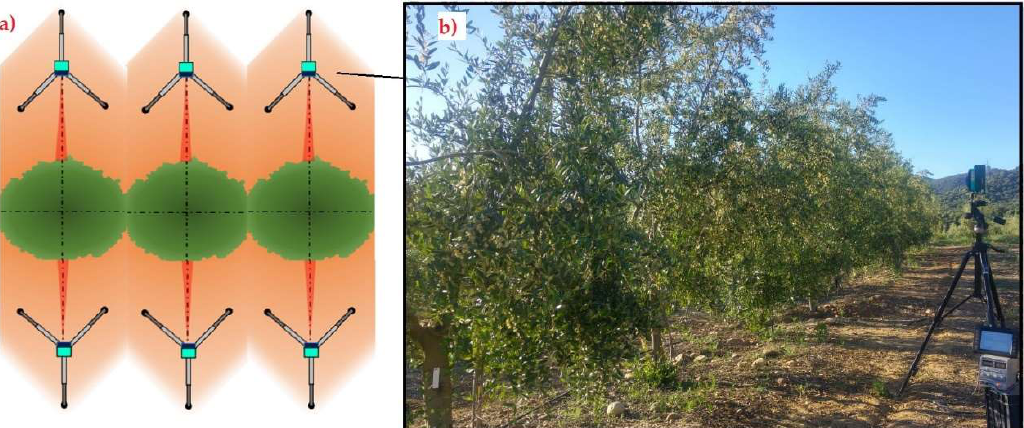
Figure 7. ( a ) Measurement location in the hedgerow trees. ( b ) Sensor measurements.